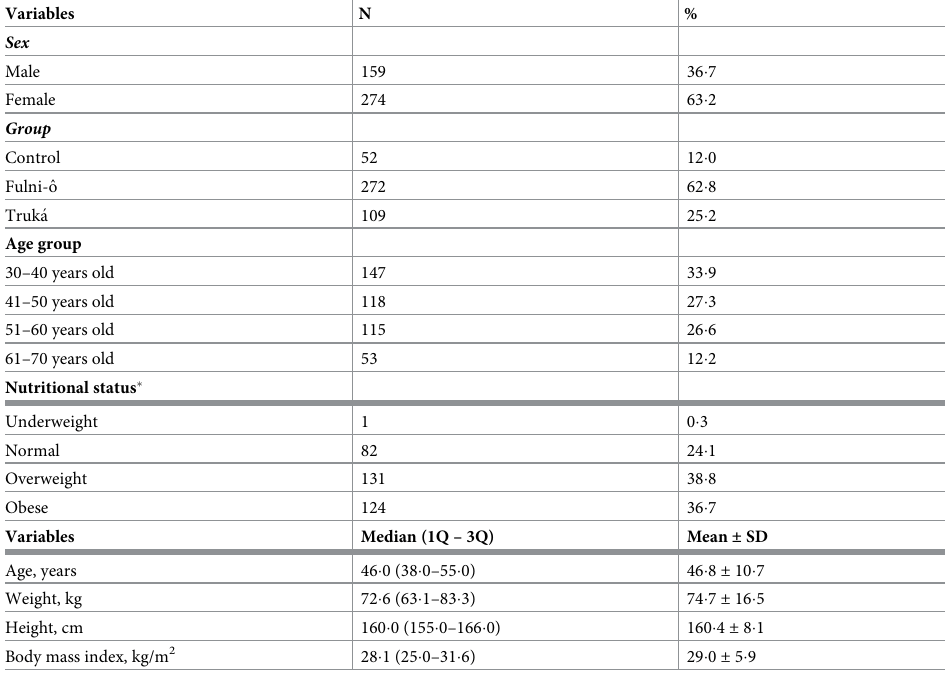
SD- standard deviation; 1Q- first quartile; 3Q- third quartile. � 95 individuals missing weight and/or height